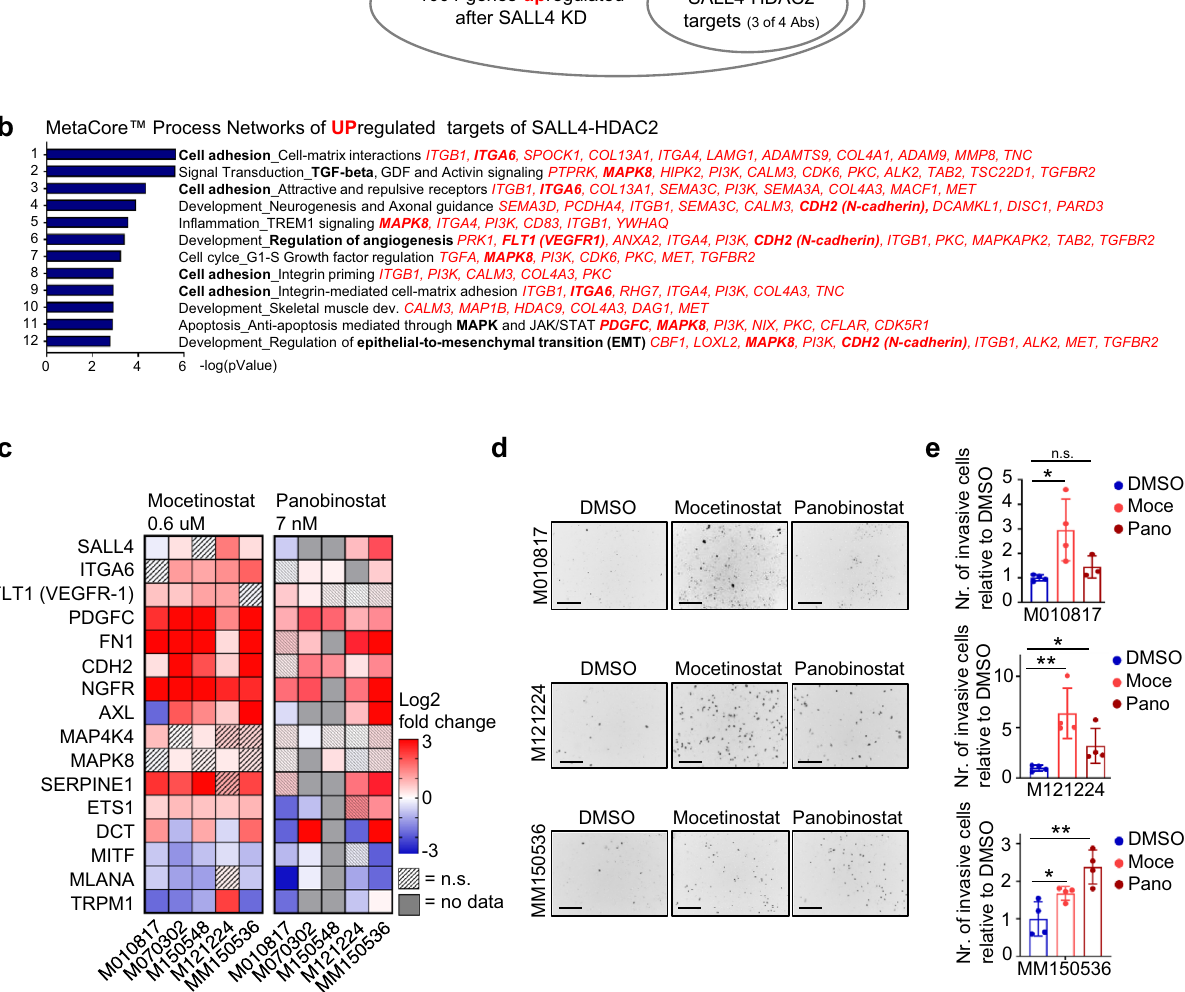
Fig. 6 SALL4-HDAC2 targets that are upregulated after SALL4 depletion or HDAC inhibition enrich in invasion-related processes. a Signi fi cantly upregulated genes after SALL4 knockdown (Fig. 4a, b) were overlaid with the C&R data of direct SALL4-HDAC2 targets (Fig. 5b, c), which resulted in 184 direct SALL4-HDAC2 targets signi fi cantly upregulated after SALL4 knockdown. b MetaCore ™ Process Network enrichment of the 184 direct targets from a . The top 12 most signi fi cant processes are given with the speci fi c genes of each process listed in red. Genes that were validated for DE in other cell lines are highlighted in bold. c Log2 fold change heatmap of qRT-PCR-based gene expression (normalized to PPIA and set relative to vehicle (DMSO)-treated samples) after 48 h cell treatment with the HDAC inhibitors Mocetinostat (0.6 µ M) and Panobinostat (7 nM). t -tests were performed for signi fi cance between HDACi and vehicle-treated groups with N = 3 and p values ≥ 0.05 = not signi fi cant (n.s.). d Images of DAPI-stained nuclei in invasion assays as in Fig. 3 i – k. Cells were seeded into the invasion chamber, which was supplemented with vehicle or 600nM Mocetinostat or 7 nM Panobinostat in both the starvation as well as the FCS high medium. After 24 h, the invaded cells were analyzed by counting DAPI-stained nuclei of invaded cells at the bottom of the membrane (inverted and set to black and white (B/W)). Scale bars 200 µ m. e Quanti fi cation of invaded cells in d set relative to control cells. Moce: mocetinostat, Pano: panobinostat. Error bars represent mean ± SD in e . For signi fi cance, two-sided t -tests were performed with N = 3 ( c ) and N = 4 ( e ) and p values ≥ 0.05 = n.s.; <0.05 = *; <0.01 = **; and <0.001 = *** with Moce in e (top panel) P = 0.0218; Moce in e (middle panel) P = 0.0051; Pano in e (middle panel) P = 0.0463; Moce in e (lower panel) P = 0.0332; Pano in e (lower panel) P = 0.0051. Source data for c and e are provided as a Source Data fi